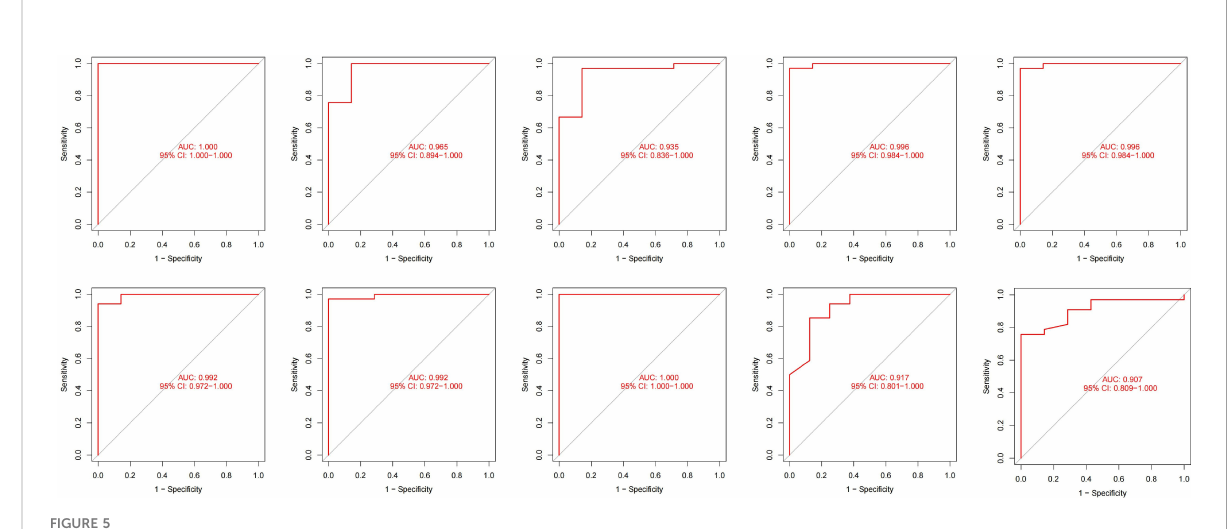
FIGURE 5 The 10-fold cross-validation veri fi es ROC curve